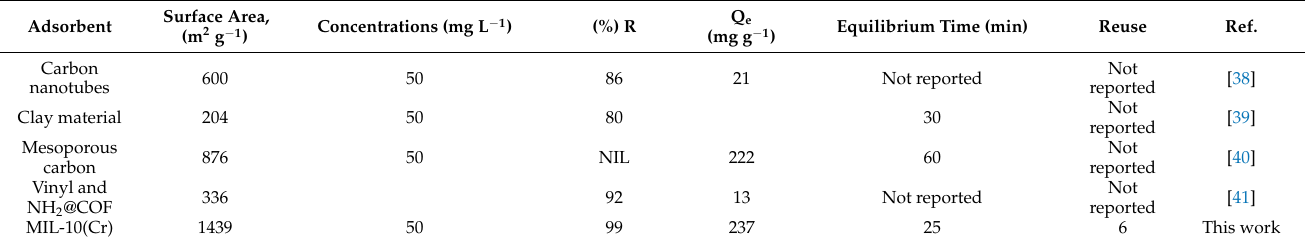
Table 7. Comparison of different materials reported for the remediation of dicamba from